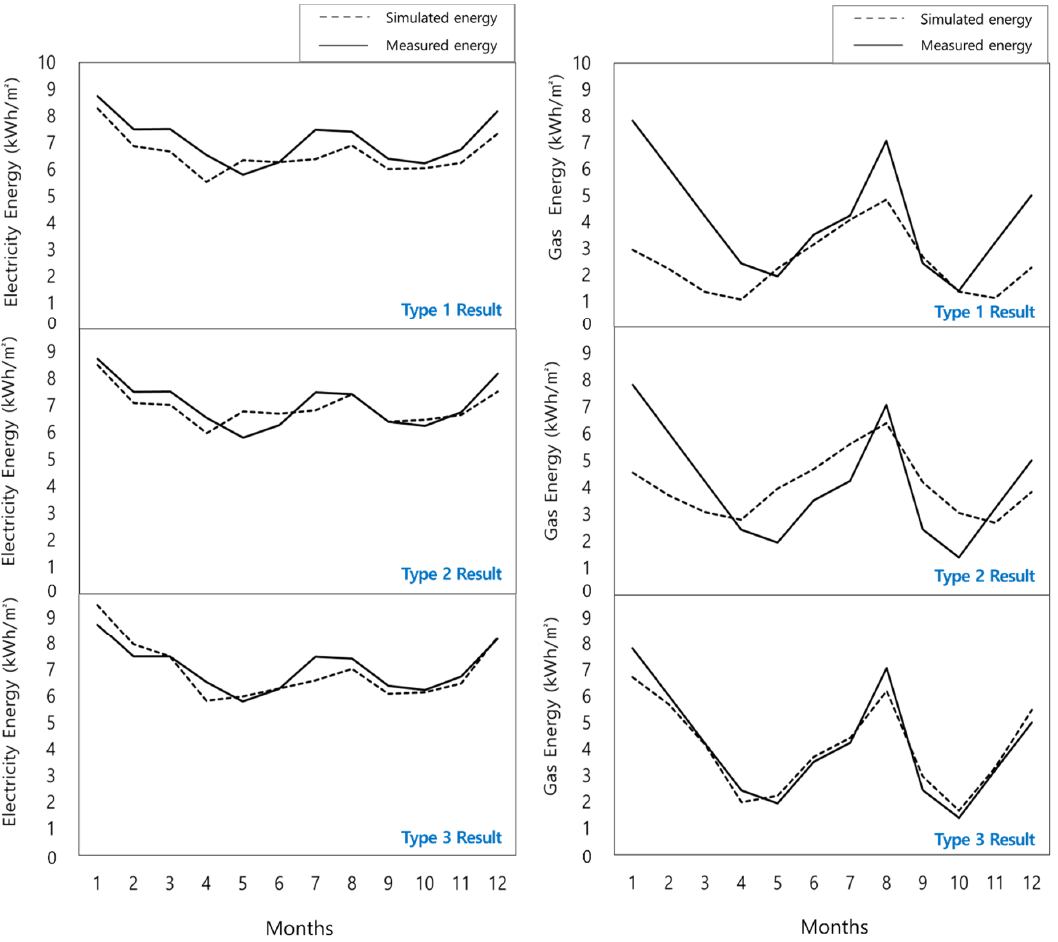
Figure 4. Simulated energy compared with measured energy. (left: electricity, right: gas) – OB1.